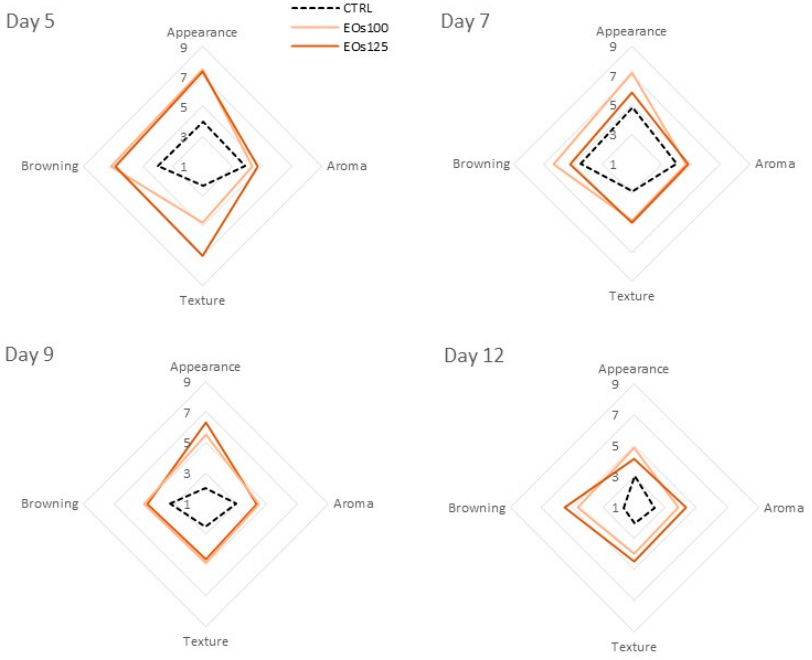
Figure 3. Sensory analyses of sliced mushroom during cold storage (4 ◦ C) under modified atmosphere packaging supplemented with vapour essential oils (100 and 125 µ L L − 1 EOs).